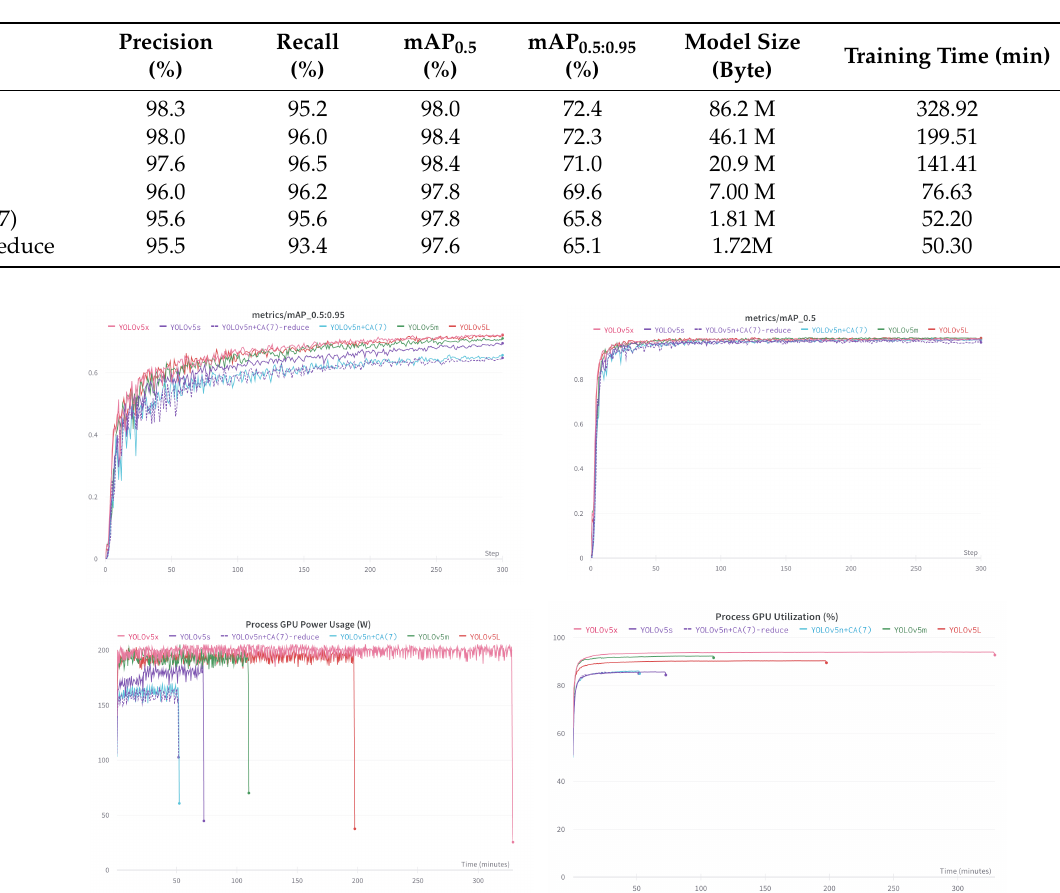
Table 3. Comparison of performance scores of YOLOv5 models with different layers and scales.